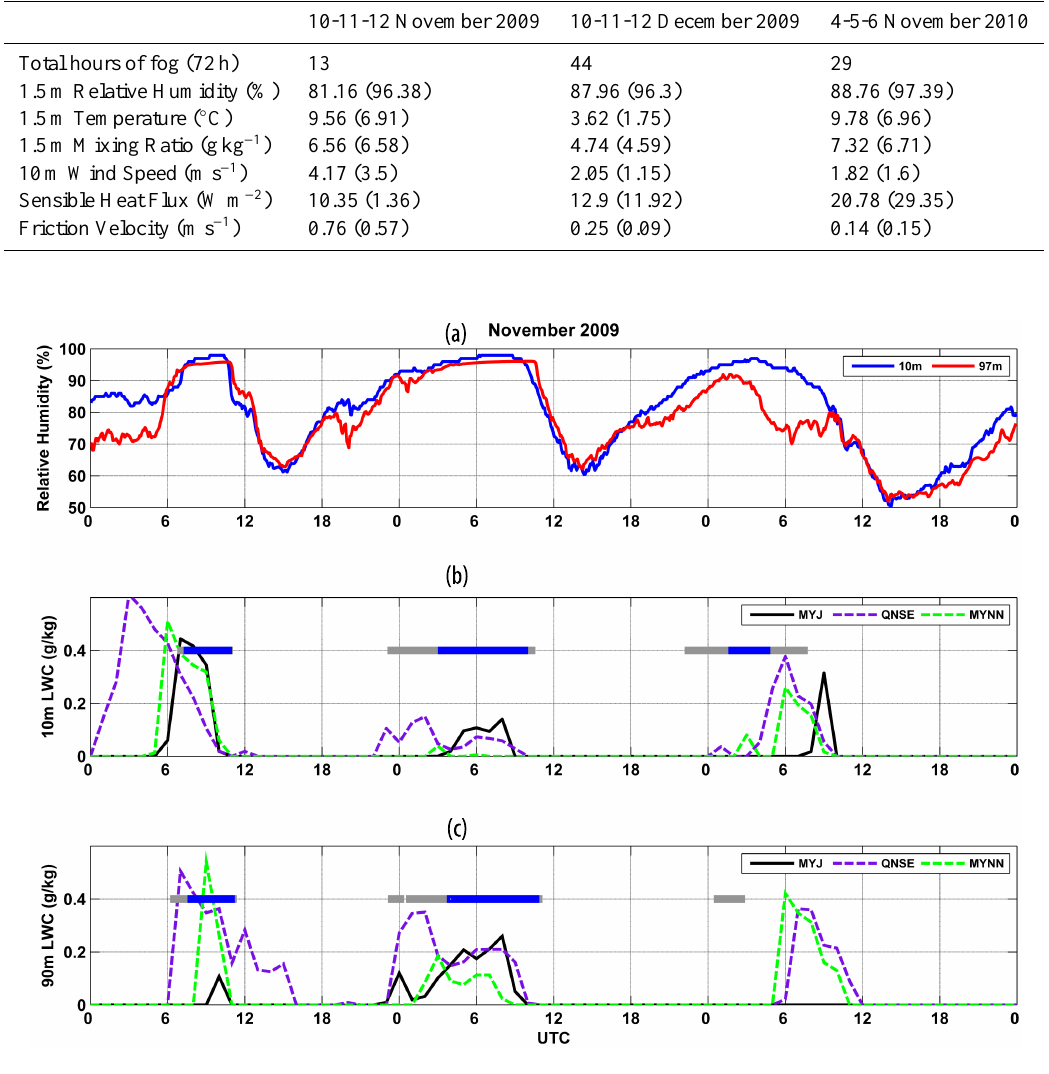
Figure 1. Analysis for 10, 11 and 12 November 2009. (a) Observed relative humidity at 10m (blue line) and 97m (red line). (b) Simulated LWC at 10m using MYJ (black line), QNSE (dashed purple line) and MYNN (dashed green line). Blue and grey rectangles indicate observed relative humidity at 10m larger than 95% and larger than 90%, respectively. (c) Same as (b) for 90m. Blue and grey rectangles indicate the same as in (b) but for